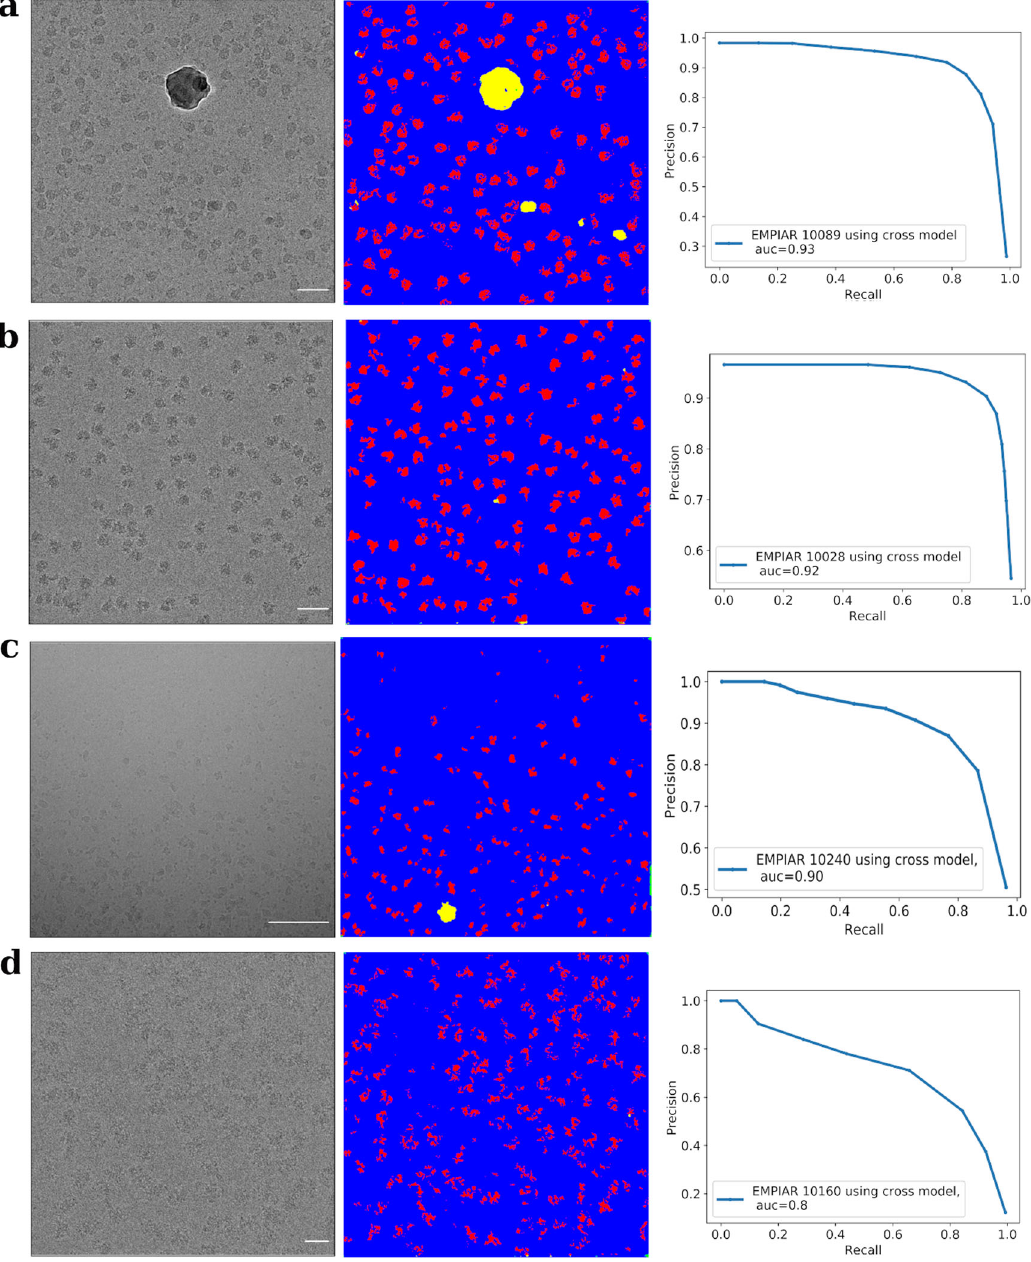
Fig. 6 Evaluation of the performance of CASSPER cross model. Panels a – d show representative unlabeled micrograph (scale bar, 50 nm), semantically segmented and labeled micrograph using CASSPER cross model and AUC curves for proteins; a TcdA1 (EMPIAR 10089), b Plasmodium falciparum 80S ribosome bound to the anti-protozoan drug emetine (EMPIAR 10028), c afTMEM16/nanodisc complex (EMPIAR 10240), and d human Bact spliceosome (EMPIAR 10160), respectively. The high values of AUC score indicate the generalization ability of CASSPER. The PR curve is obtained by comparing the coordinates with manually picked ground truth